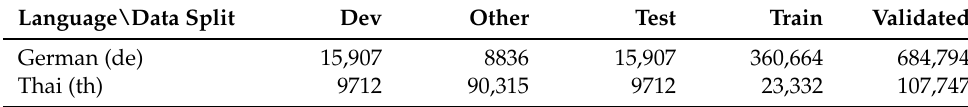
Table A1. Number of examples in Common Voice 7.0 German and